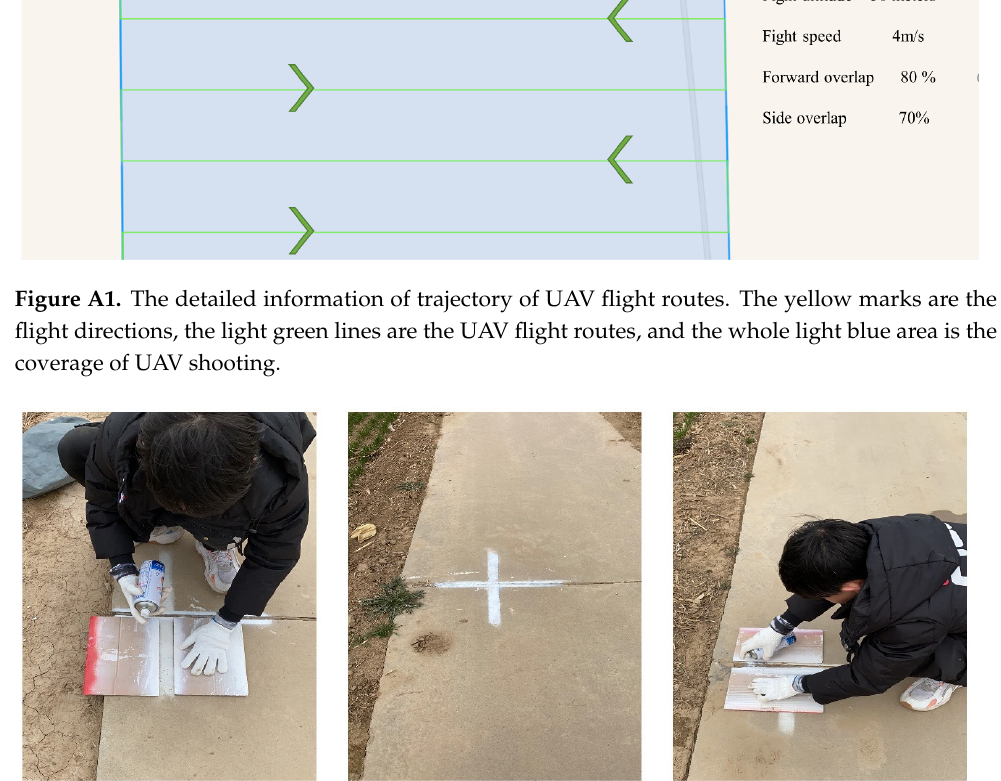
Figure A2. The detailed information of the Ground Control Point (GCP). The GCP was made using white paints, and the locations were measured using S86 system. Table A1. The conduction of NPK fertilizers in 20 plots. The number in the table indicates the series number of the plots. The N fertilizer was urea, P fertilizer was calcium phosphate, and K fertilizer was potassium chloride. The numbers under the plots are the series number of plots. The number after the N, P, K represents the applied amounts of the fertilizers, and 1 indicates the 30 kg/ha. Plots Fertilizers Plots Fertilizers Plots Fertilizers Plots